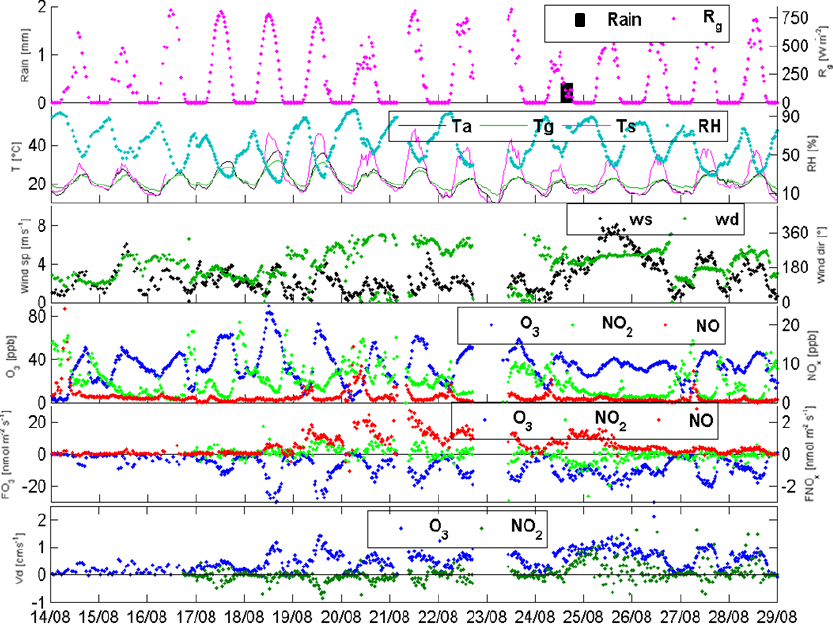
Figure 8. Meteorological variables and NO x –O 3 mixing ratios and fluxes measured during the period 14 to 29 August 2012 at the Grignon field site. Ticks on the x axis correspond to